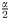
When the phylogenetic tree is ultrametric, clustering is trivial.For a threshold α, cut the tree at α2 height (A). When the tree is not ultrametric, it is not obvious how to cluster leaves (B). In both cases, a set of cut edges defines a clustering.